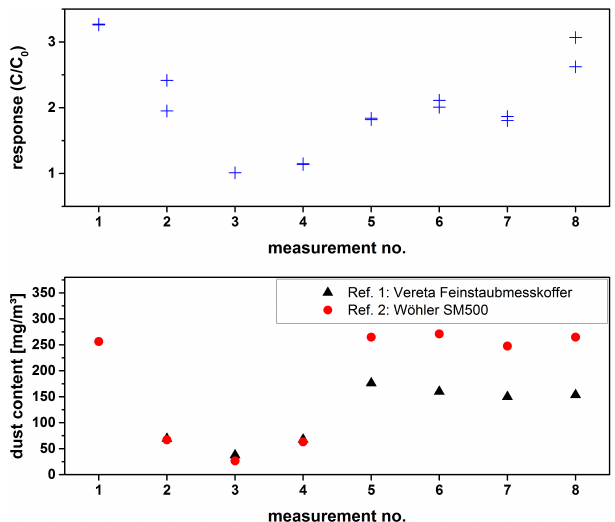
Figure 6. Comparison of the response ( C/C 0 ) of two IDE sensors at a frequency of 16.3kHz with values from two reference instru- ments. The response of both IDE sensors overlap at several points due to their small deviation. The fuels are HTC char (no. 1, no. 2), beech briquette (no. 3, no. 4), Pini&Kay briquette beech (no. 5, no. 6), Pini&Kay briquette spruce (no. 7, no. 8). The deposition time is 15min according to the 1st BImSchV requirements of the reference